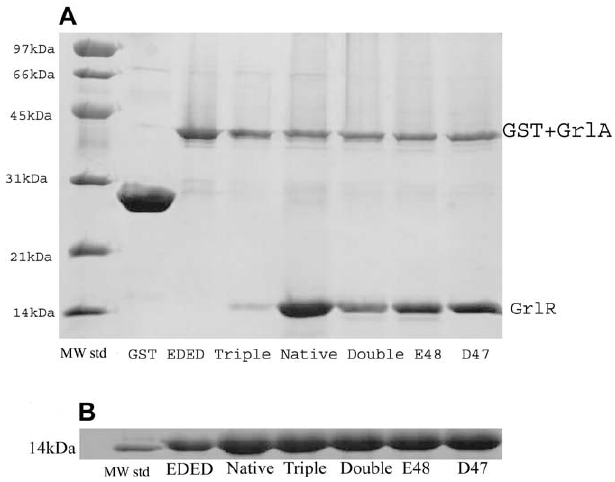
Figure 4. In Vitro Pull-Down Assay (A) SDS-PAGE gel showing the in vitro pull-down assay to demonstrate the binding of wild-type GrlR and EDED mutants to GrlA. Lane 1, molecular weight marker (MW); lane 2, GST; lane 3, E46A-D47A-E48A- D49A; lane 4, E46A-D47A-E48A; lane 5, wild-type GrlR; lane 6, E46A-D47A; lane 7, E48A; lane 8, D47A. The bands corresponding to GST-GrlA and GrlR were further identified by peptide mass finger printing. The staining was done using coomassie brilliant blue. (B) SDS-PAGE gel showing the amount of native and mutant GrlR protein used for the in vitro pull-down assay. Lane 1, molecular weight marker; lane 2, E46A-D47A-E48A-D49A; lane 3, wild-type GrlR; lane 4, E46A-D47A- E48A; lane 5, E46A-D47A; lane 6, E48A; lane 7, D47A. doi:10.1371/journal.ppat.0030069.g004 PLoS Pathogens |